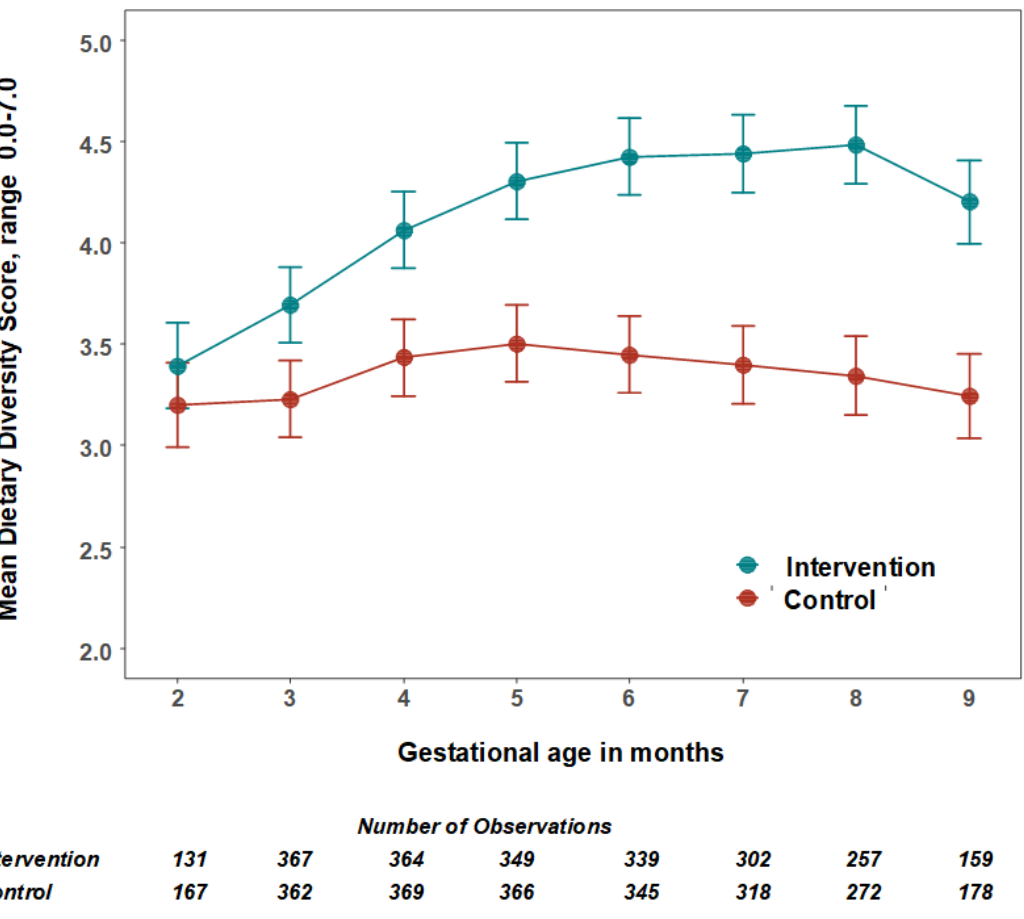
Figure 2. The mean number and 95% confidence intervals of food groups consumed by women per day by treatment group. The estimated mean number of food groups consumed per 24 h, and 95% confidence intervals were calculated using multilevel linear mixed models with study arms (intervention = 1 and control = 0) and gestational months (2–9) as fixed effects with an interaction term between them and two random effect variables for adjusting the cluster RCT design and the repeated